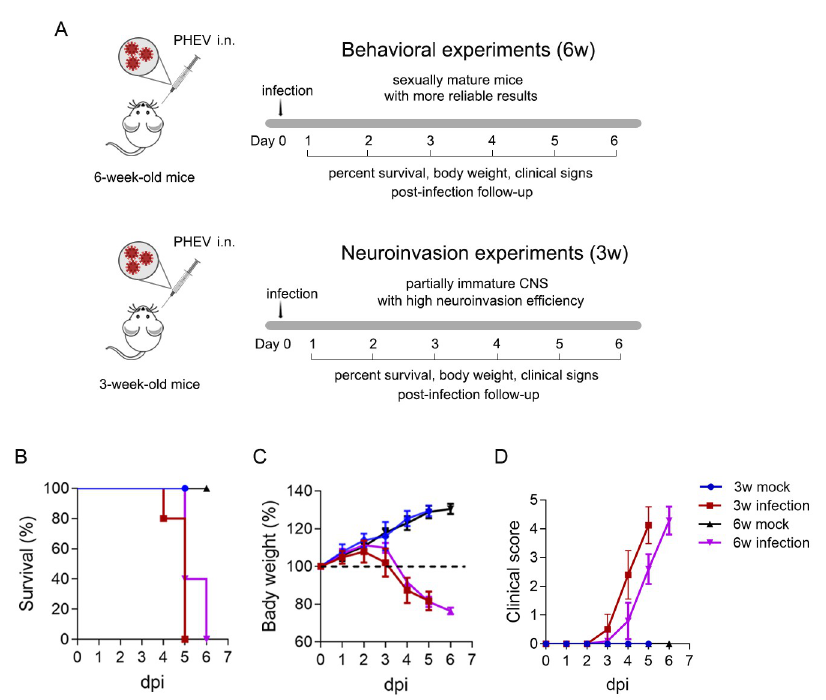
Fig 1. Intranasal inoculation of PHEV in BALB/c mice results in lethal infection. Three-week-old (3w) and six- week-old (6w) BALB/c mice were mock-infected (n = 3/sex/age) or intranasally inoculated (n = 5/sex/age) with 10 3.96 TCID 50 PHEV. (A) Schematic diagram of the study design and workflow. Mice were monitored daily for survival ( B ), relative weight change ( C ), and clinical signs ( D ). Statistical analyses were performed using log-rank (Mantel–Cox) tests (B), Wilcoxon matched-pairs rank test (C), and one-way ANOVA, two-tailed Student’s t test (D). Data are representative of three replicate experiments and are shown as the means ± SD.